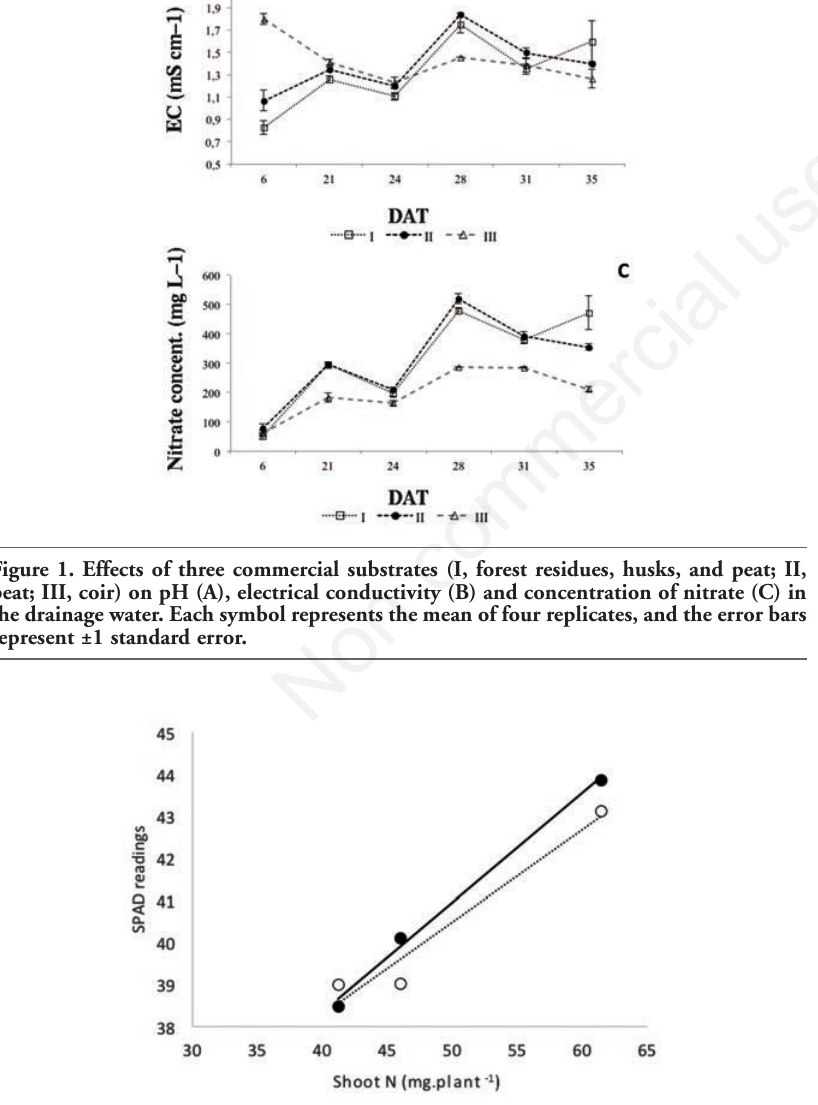
Figure 2. Relationship between shoot N (mg×plant–1) and leaf chlorophyll (SPAD meter readings) at 24 (  ) and 36 (  ) days after transplanting (DAT) in spinach. SPAD read- ings (24 DAT)=0.22 mg/plant N+29.5 (r2=0.9513, P<0.0001); SPAD readings (36 DAT)=0.26 mg/plant N+27. 9 (r2=0.9943,